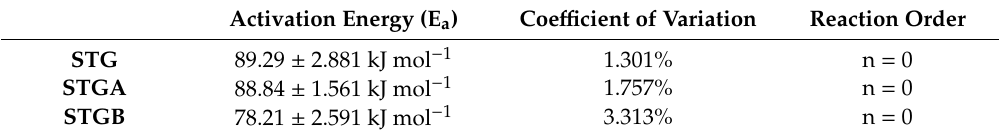
Table 1. Kinetics parameters obtained for STG, STGA and STGB in non-isothermal kinetics analysis.